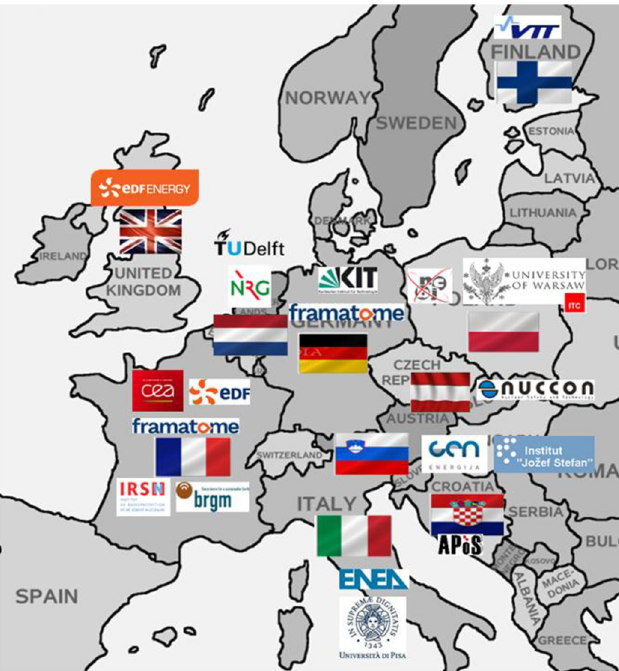
Fig. 4. The NARSIS consortium at a